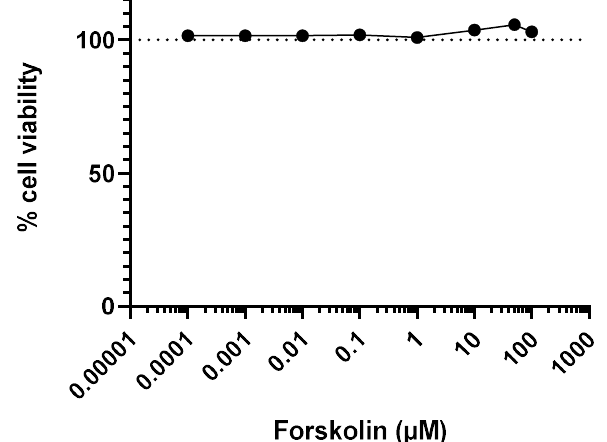
Figure 1. Cell viability evaluation using the alamar blue assay after a 72-h incubation time with forskolin.